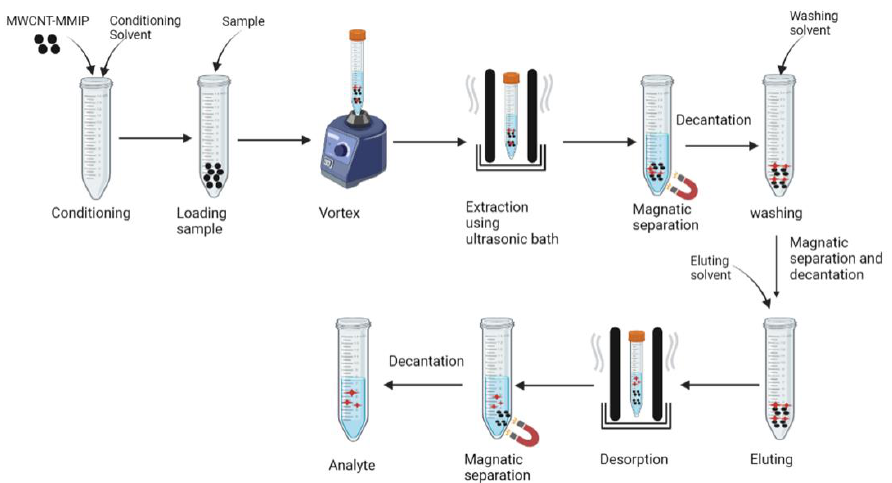
Figure 3. Procedure for extraction using ultrasonic-assisted dispersive solid-phase microextraction method (UA@DSPME).